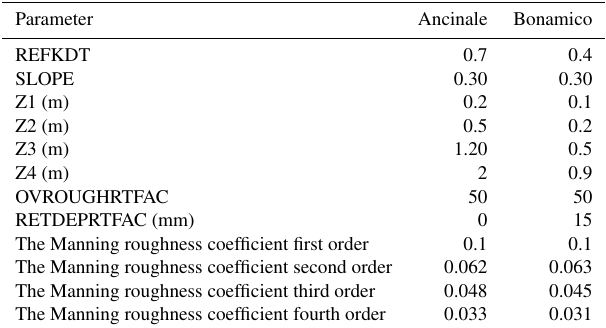
Table 3. Calibrated parameters of the offline WRF-Hydro model for the Ancinale River and the Bonamico Creek. Parameter Ancinale Bonamico